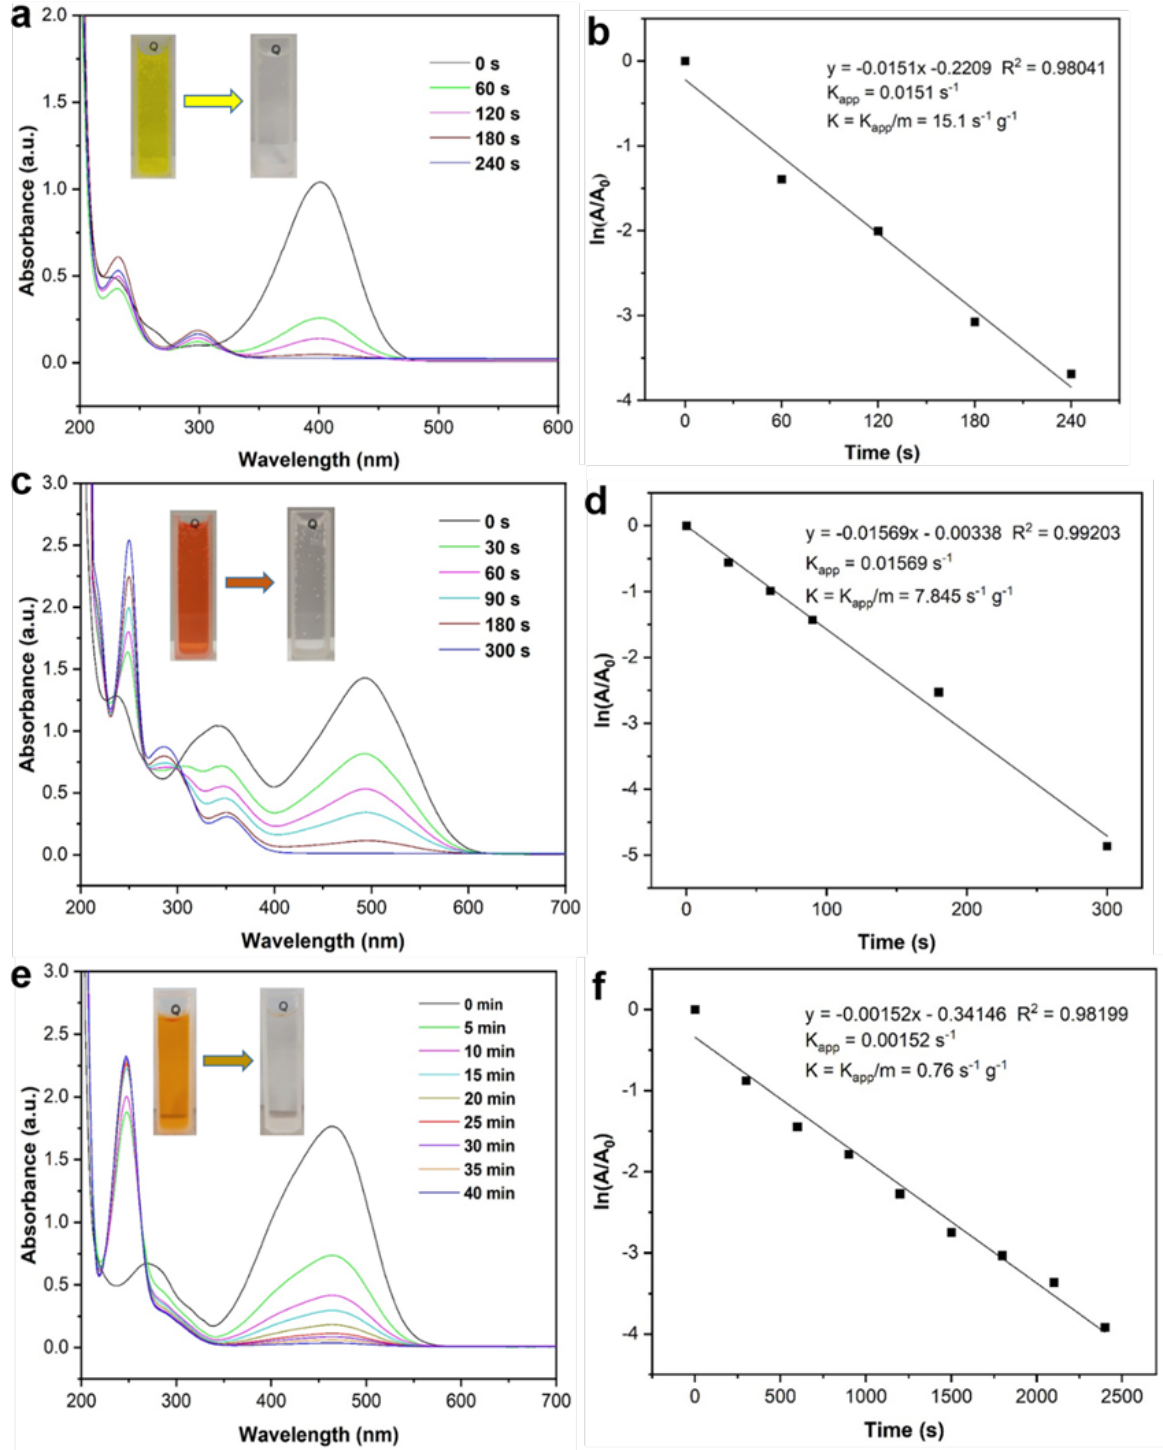
Figure 6. Time-dependent UV – vis spectra for ( a ) 4-NP, ( c ) CR, and ( e ) MO reduction by NaBH 4 in the presence of Ni-Pd/Fe 3 O 4 catalyst. Insets in Figure 4b,c are the photographs showing the color fading of the reaction mixture. Rate constant versus time for ( b ) 4-NP, ( d ) CR, and ( f ) MO reduction by NaBH 4 in the presence of Ni-Pd/Fe 3 O 4 catalyst.